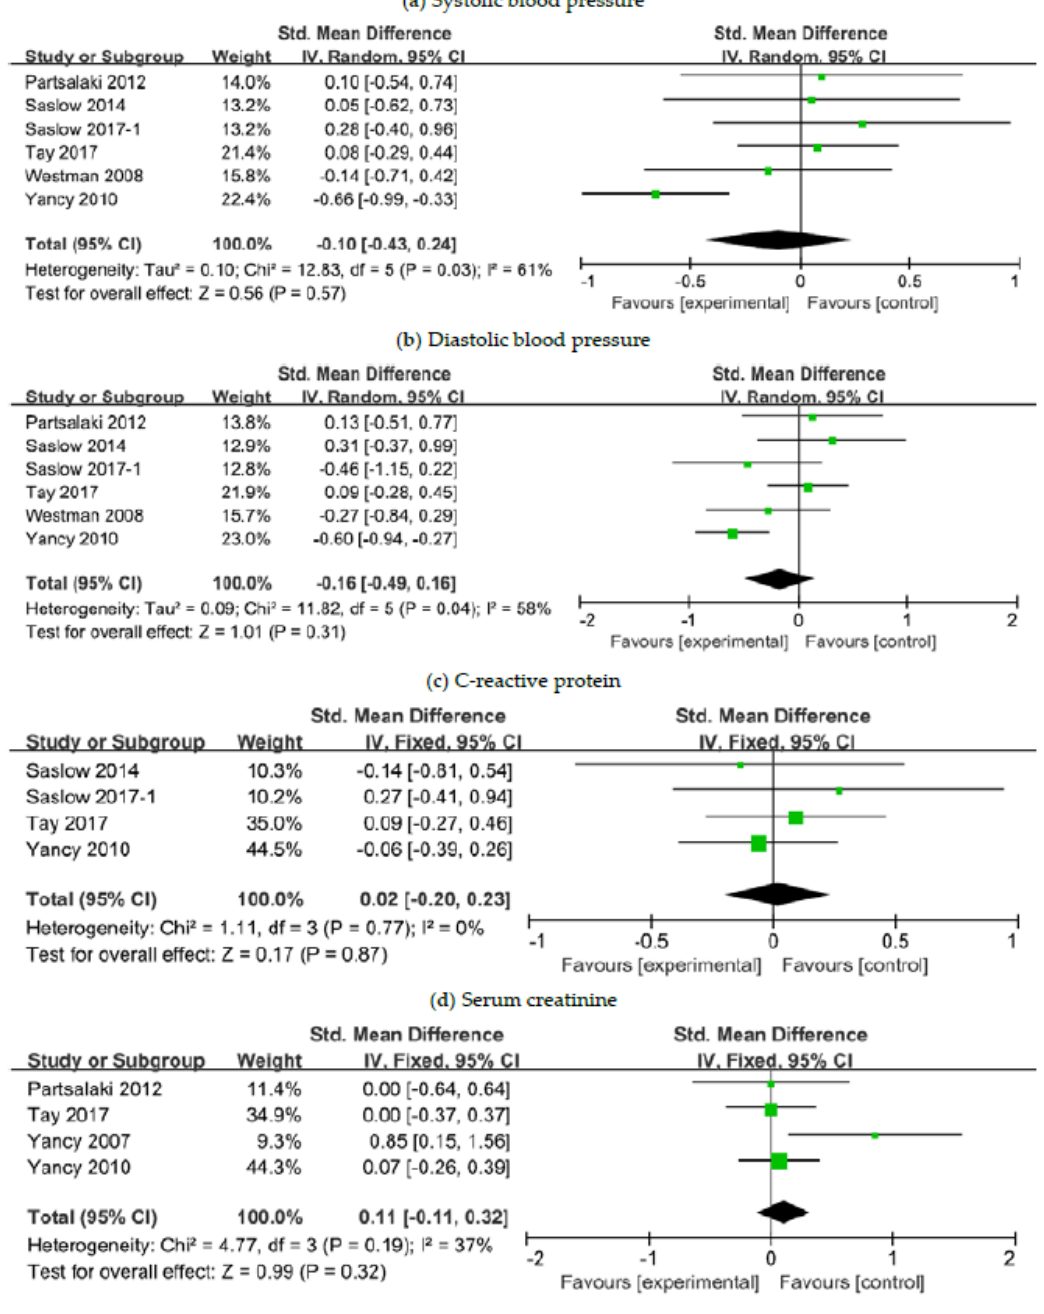
Figure 6. Forest plots for association between other risk markers and ketogenic diet in patients with overweight or obesity and with or without T2DM: ( a ) Changes in systolic blood pressure; ( b ) changes in diastolic blood pressure; ( c ) changes in C-reactive protein; ( d ) changes in serum creatinine. Abbreviations: CI, confidence interval; T2DM, type 2 diabetes mellitus.